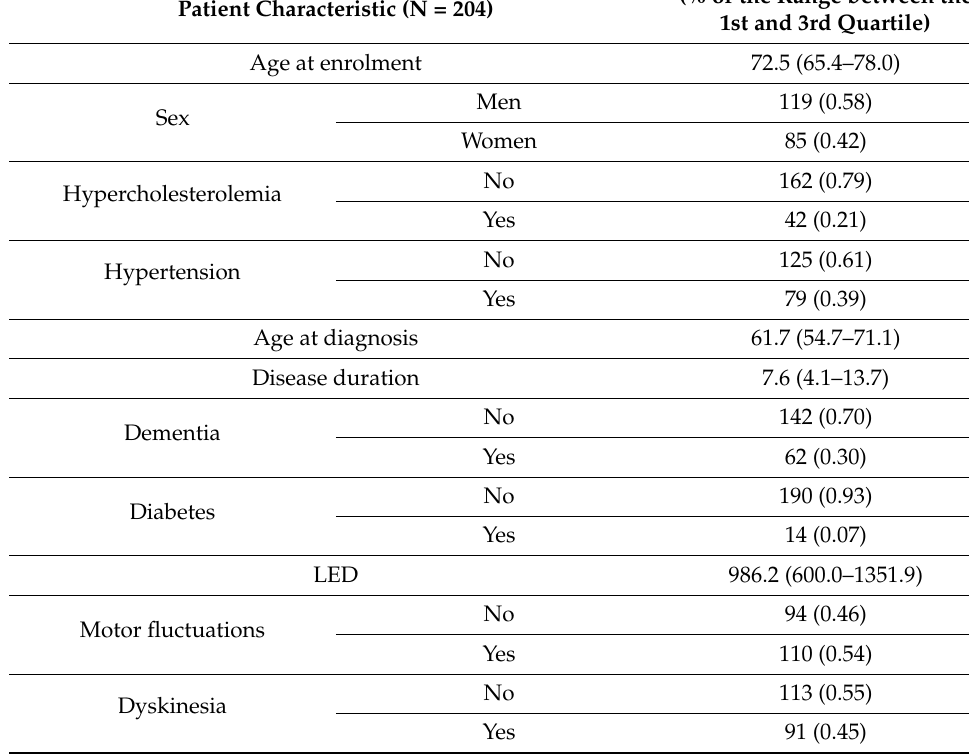
Table 1. Patients